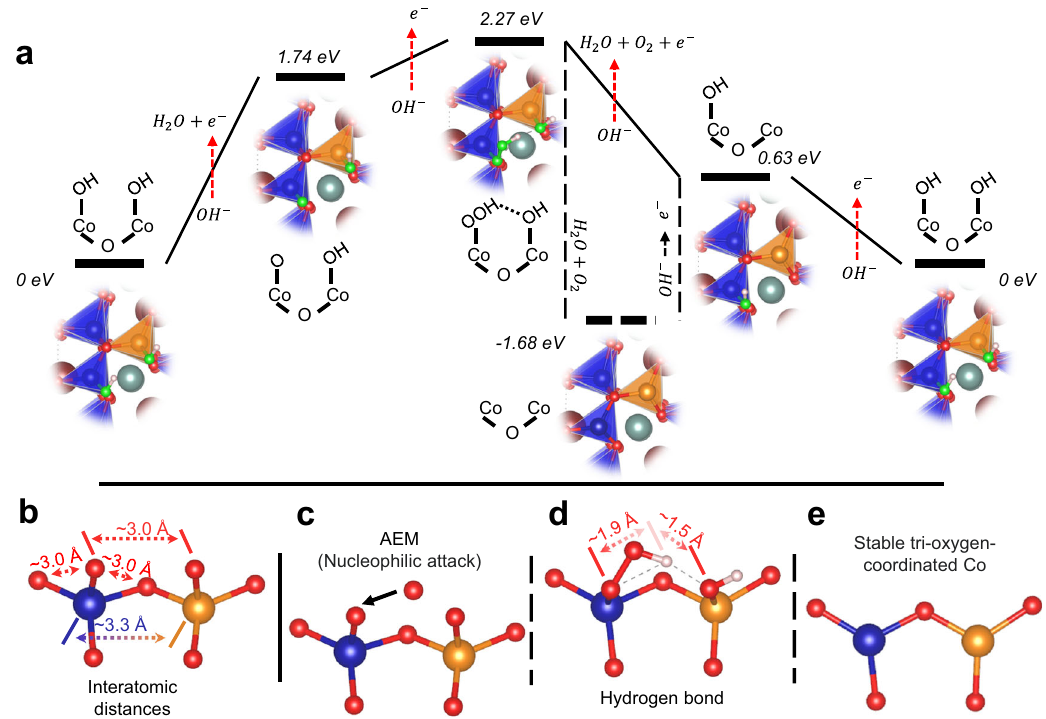
Fig.4|Hydrogenbond.a ThecalculatedmostlikelypathsintheOERontheYBC4 (110) surface. The free energies of different possible surface statuses in each proton-coupled electron transfer step are also presented. The O involved in the